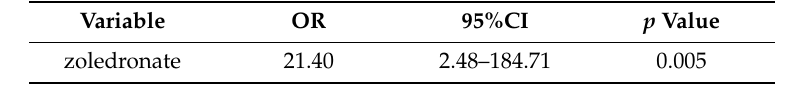
Table 4. Result of multivariate logistic regression analysis using the backward elimination